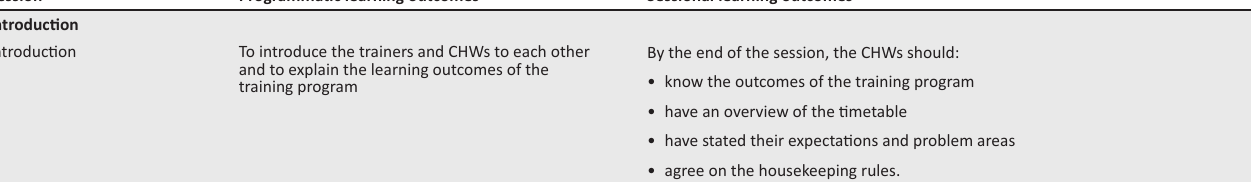
TABLE 5: Key programmatic outcomes (aims) and learning outcomes of the 16